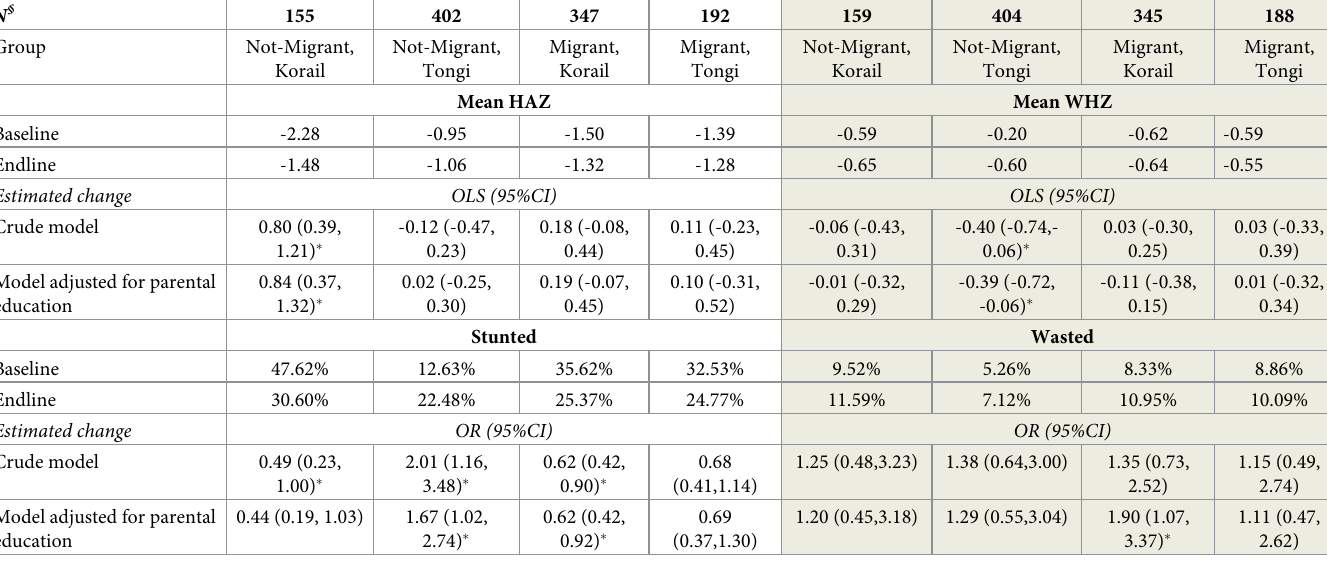
Table 4. Estimated changes in child nutritional status between baseline and endline (by subgroups according to household migration status and slum